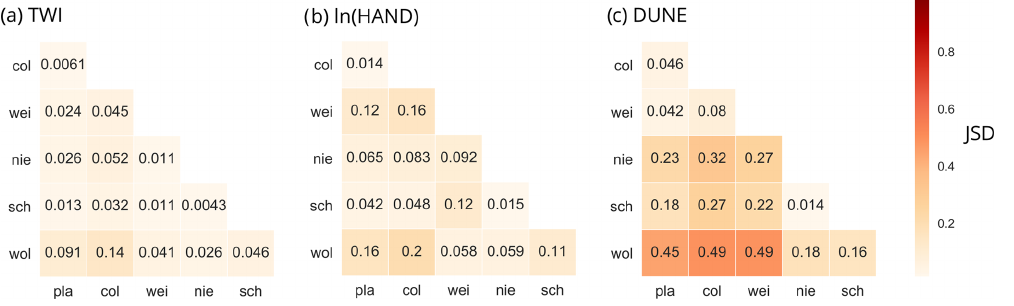
Figure 4. JSD values for the six research catchments: schist – Platen (pla), Colpach (col) and Weierbach (wei) – and marl – Niederpallen (nie), Schwebich (sch) and Wollefsbach (wol). (a) JSD between the TWI distributions, (b) between the ln(HAND) distributions and (c) between the rDUNE distributions. A high JSD value indicates a high divergence between the distributions, with a maximum of